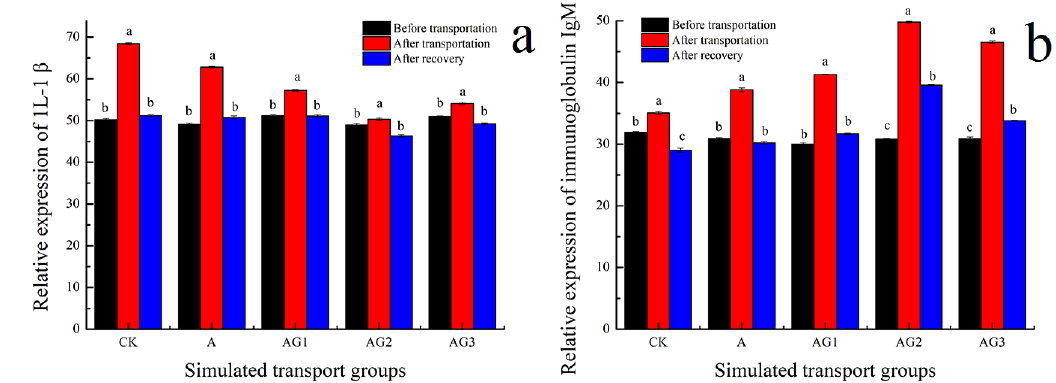
Figure 6. E ff ect of ascorbic acid and β -1,3-glucan addition on relative expression of 1L-1 β ( a ) and IgM Figure 6. Effect of ascorbic acid and β-1,3-glucan addition on relative expression of 1L-1β ( a ) ( b ) of tiger grouper during simulated transport. Among di ff erent treatments transport groups, di ff erent and IgM ( b ) of tiger grouper during simulated transport. Among different treatments small letters indicate the results of Duncan’s test at di ff erent transport time. The same letters mean no transport groups, different small letters indicate the results of Duncan’s test at different significant di ff erence ( p > 0.05), while di ff erent letters mean significant di ff erence ( p < 0.05). Di ff erent transport time. The same letters mean no significant difference ( p > 0.05), while different letters without * = p -value < 0.05, di ff erent letters with ** = p -value < letters mean significant difference ( p < 0.05). Different letters without * = p- value < 0.05, different letters with ** = p- value < 0.01.